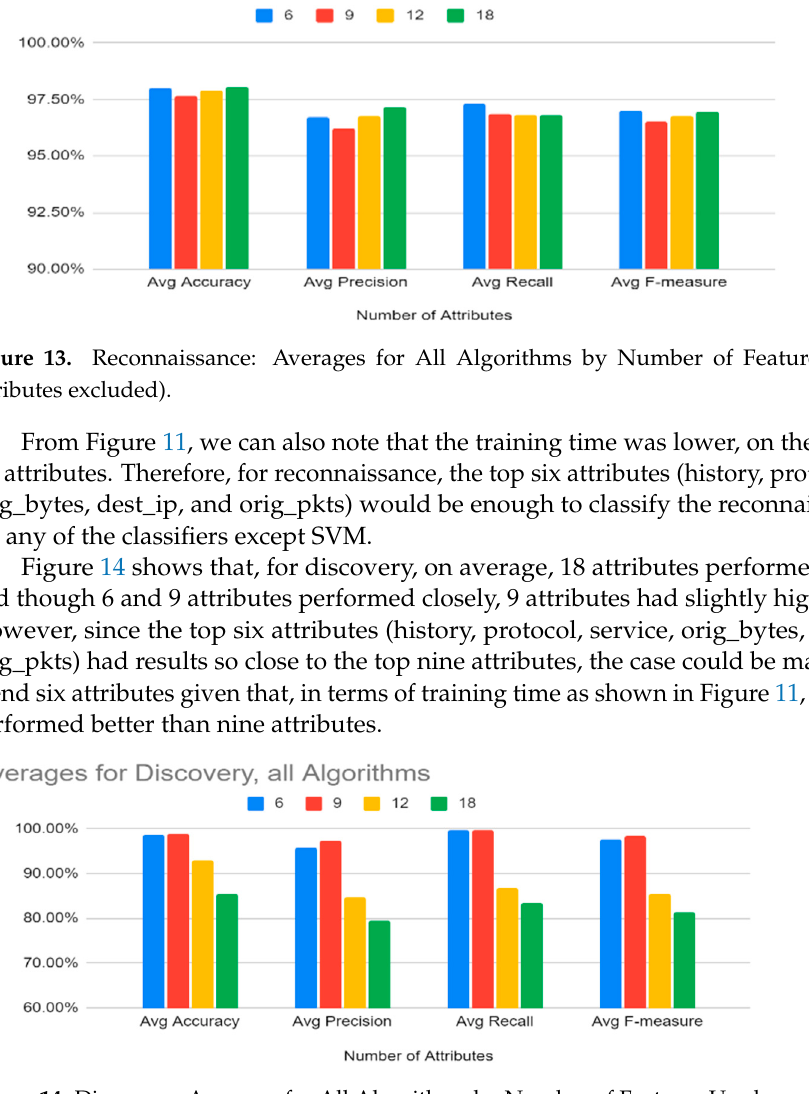
Figure 14. Discovery: Averages for All Algorithms by Number of Features Used.